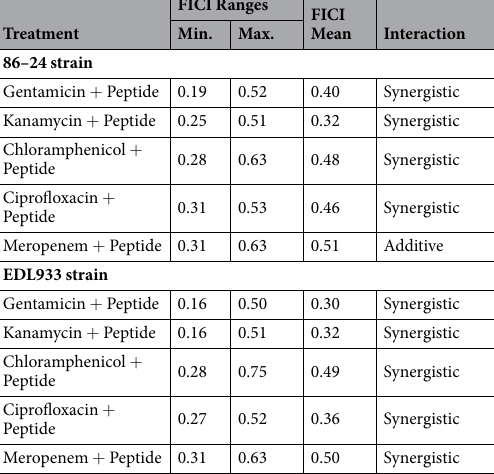
Table 2. Fractional inhibitory concentration indices calculated for peptide antibiotic combinations that inhibited STEC strains 86–24 and EDL933. All assays were carried out in triplicate and on at least two different